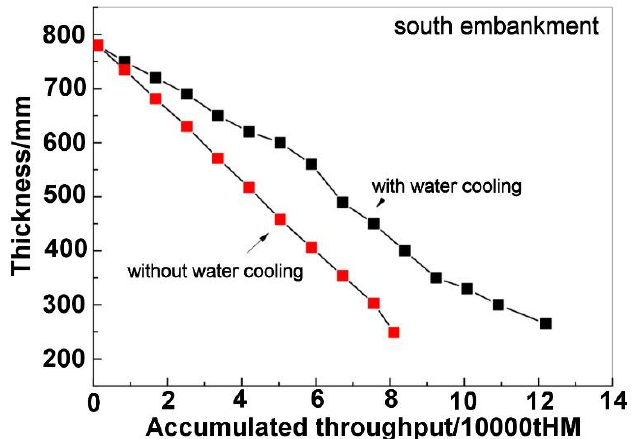
Figure 5. Relation between the top thickness of the north embankment and the accumulated throughput.